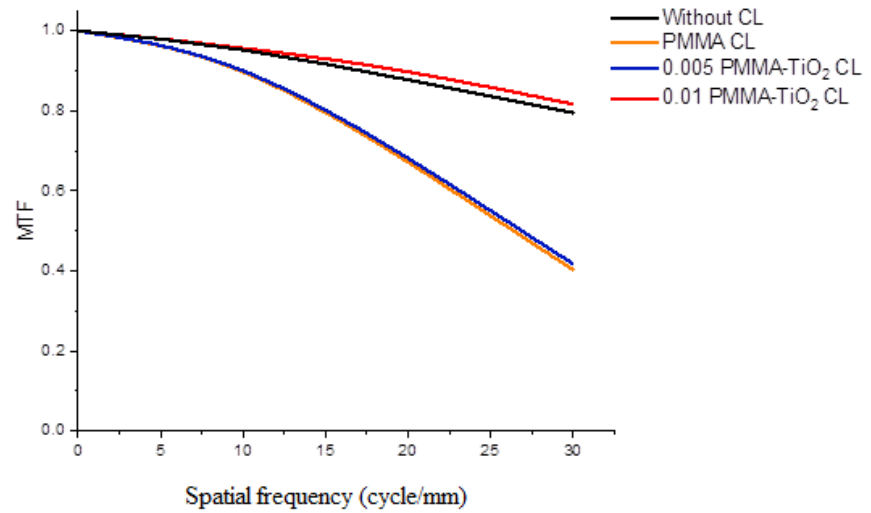
Figure 5. Polychromatic modulation transfer function (MTF) simulation curves of prepared contact lenses (CLs) in compare with a free eye.